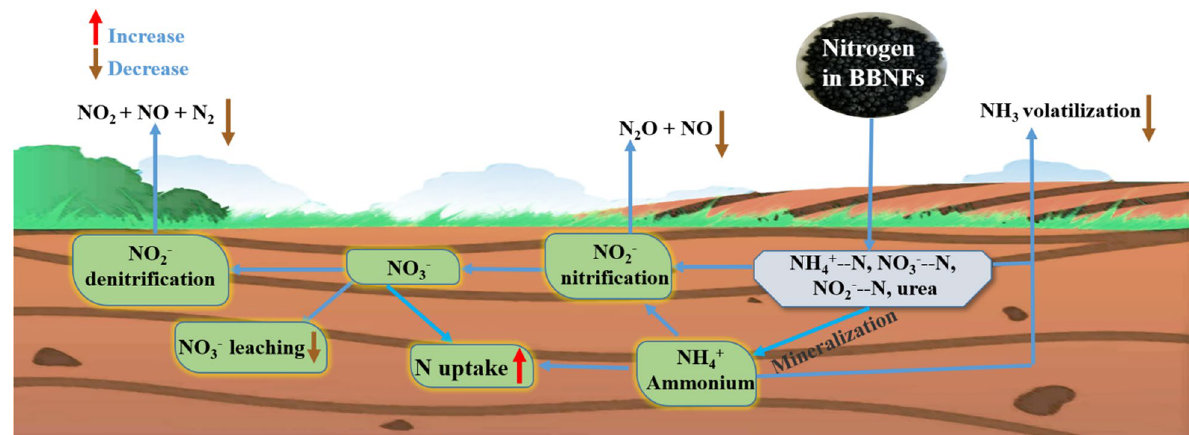
Fig. 3 The modification of N cycling processes in soil following BBNFs